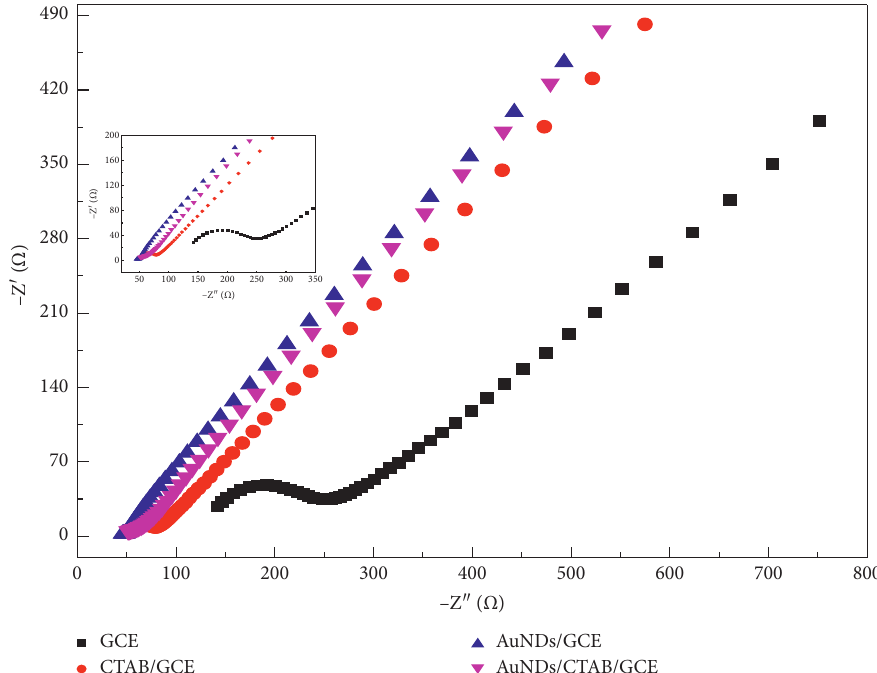
Figure 2: Nyquist diagrams of GCE, CTAB/GCE, AuNDs/GCE, and AuNDs/CTAB/GCE in the solution containing 5 mM Fe(CN) 63 − /4 − and 0.1 M PBS. Parameters are as follows: Frequency range from 0.1 Hz to 10000Hz, initiative potential: 0.23V, amplitude:10mV, and quiet time of